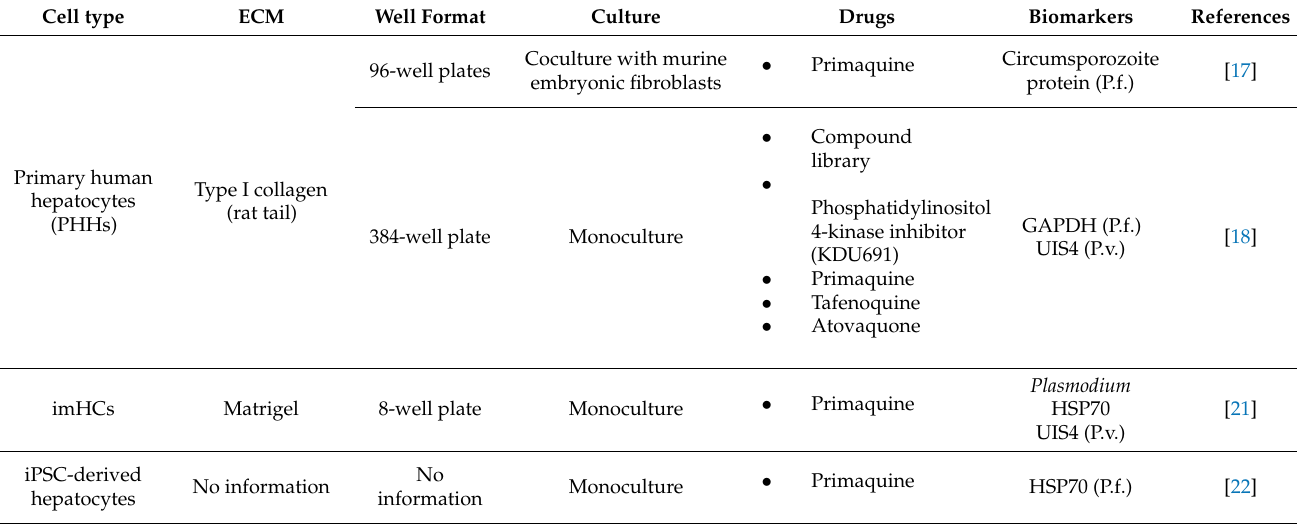
Table 2. In vitro models for plasmodicidal activity assays against human liver-stage